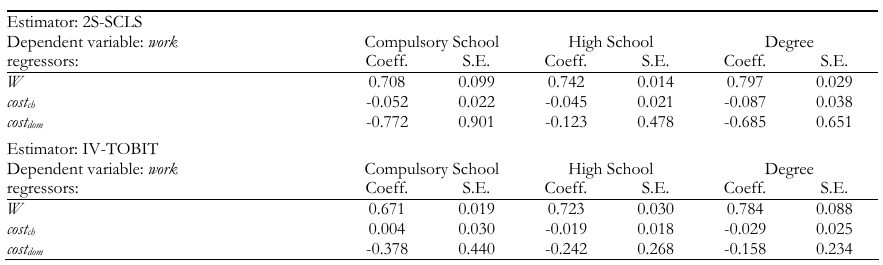
Wage-elasticity and unpaid-work elasticity estimated coefficients in the female paid-work equation for different education level